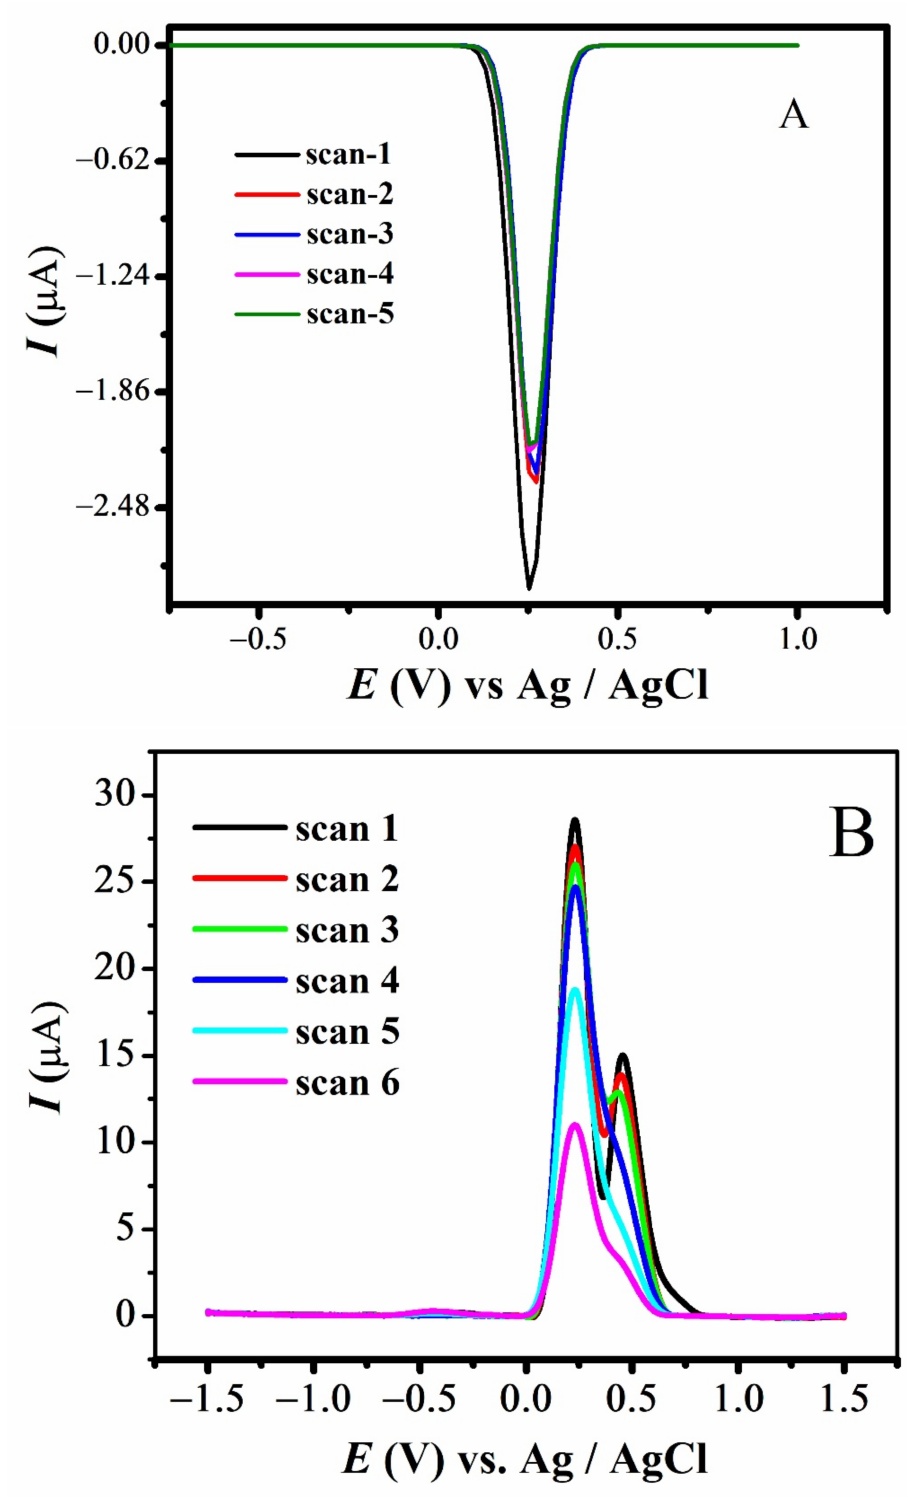
Figure 8. SWV Consecutive scans of ( A ) FBA and ( B ) FMA without cleaning